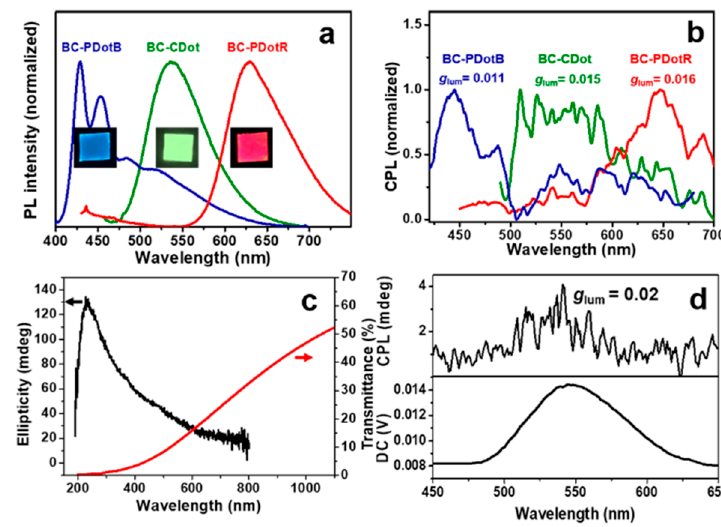
Figure 4. ( a ) Photoluminescence spectra of BC-luminophore papers and corresponding photographs under 365 nm irradiation. ( b ) CPL spectra of the BC-luminophore papers. ( c ) CD (left vertical axis) and UV–vis transmission spectra (right vertical axis) of cellulose-CDot paper. ( d ) CPL spectrum of the cellulose-CDot paper.